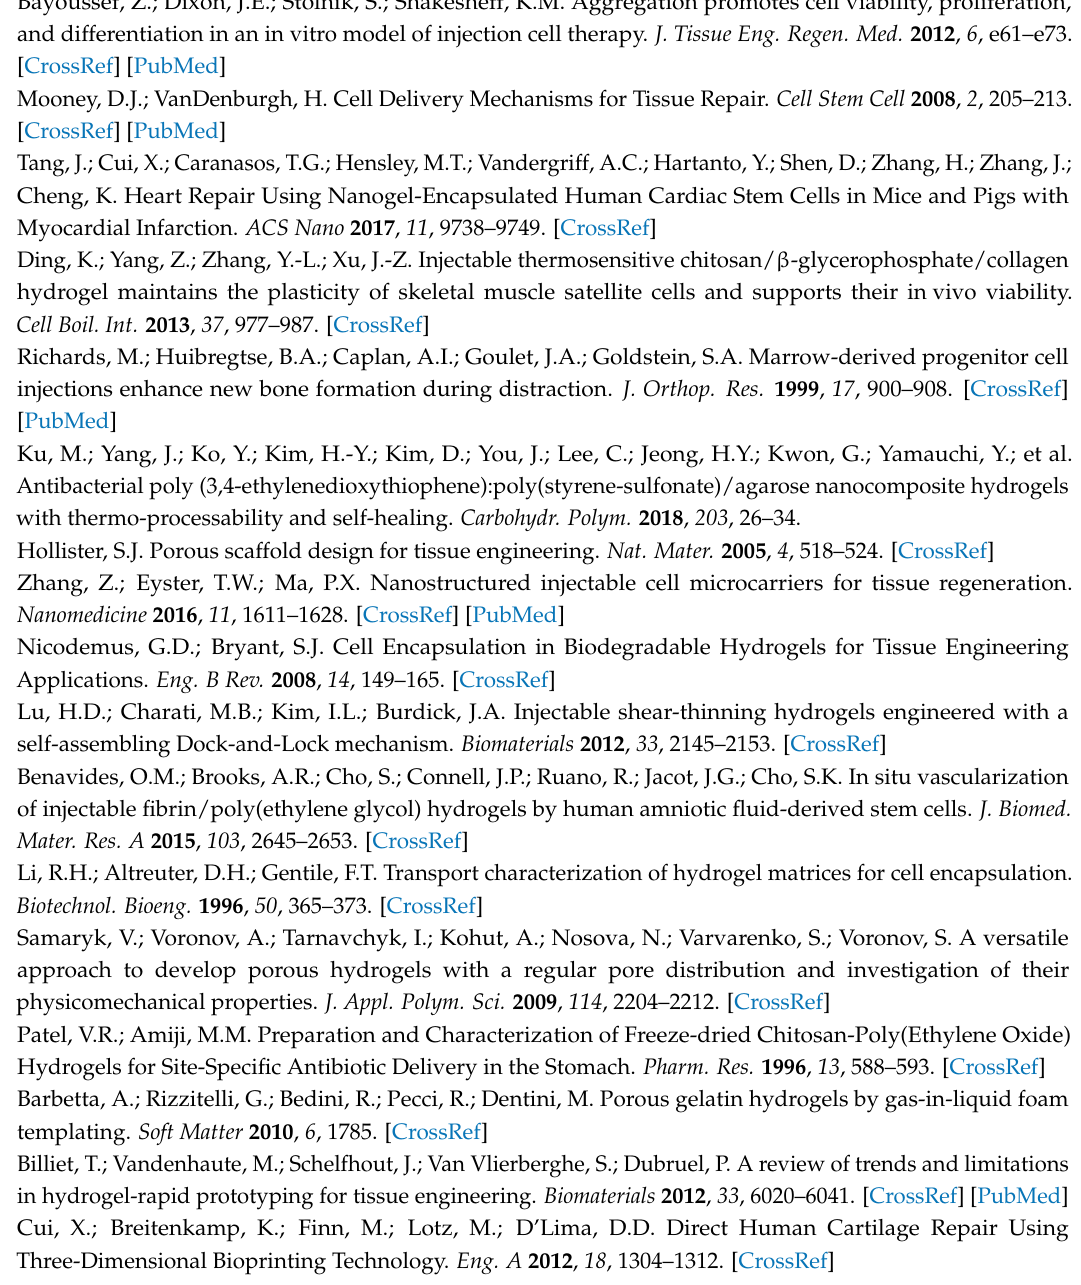
Figure S1: Effect of CaCl 2 flow rate on microfiber diameter, Figure S2: cells released from microfibers at the bottom of the cell culture